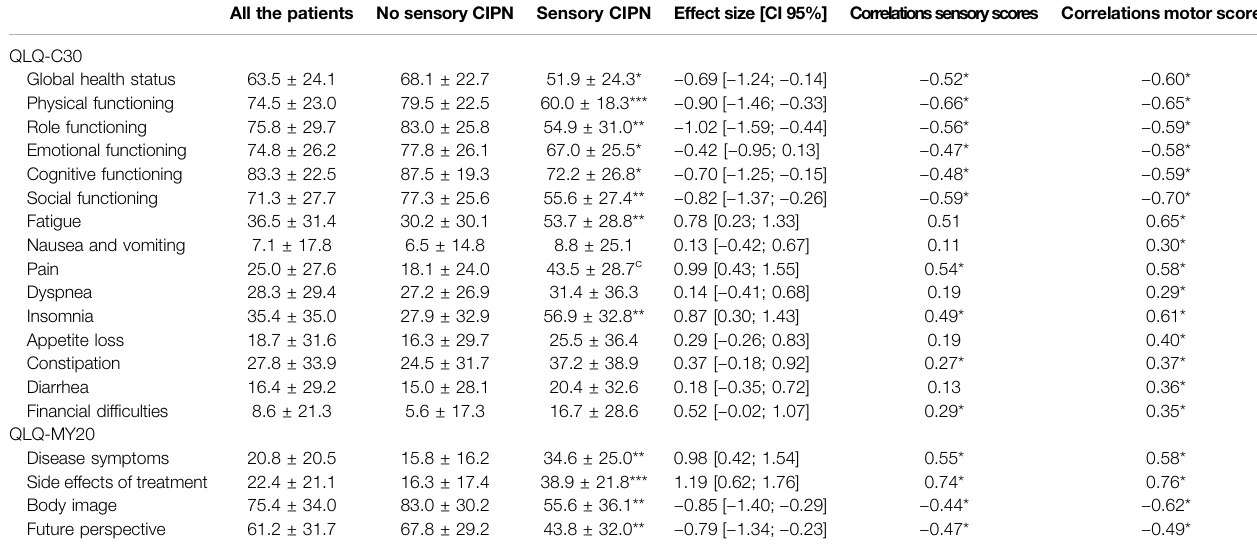
TABLE 4 | Scores of quality of life (QLQ-C30 and QLQ-MY20) according to sensory CIPN, and correlation with sensory and motor scores of the QLQ-CIPN20. All the patients No sensory CIPN Sensory CIPN Effect size [CI 95%] Correlationssensoryscores Correlationsmotor